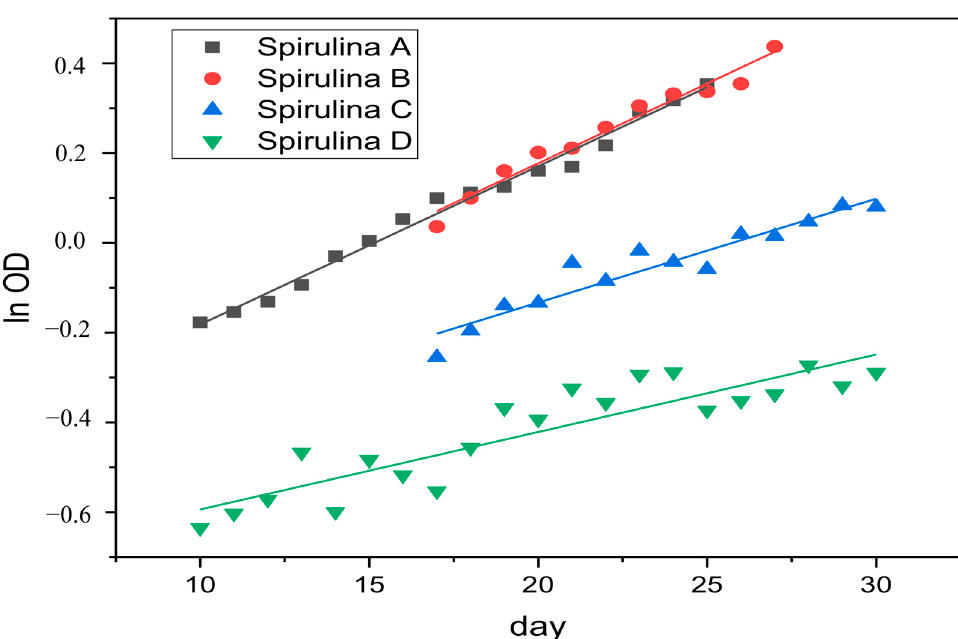
Figure 3. The logarithmic of optical density of S. platensis at the exponential phase in brackish water in various concentrations of microplastic treatment ( A ) control, ( B ) 150 mg, ( C ) 250 mg, and ( D ) 400 mg. Table 1. Means value and their variances of each experiment.